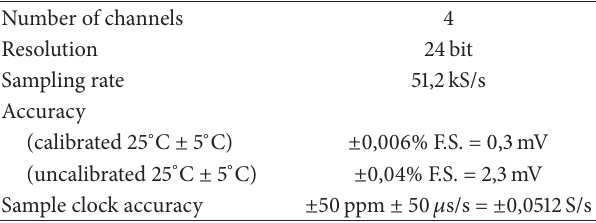
Table 5: IEPE module (NI9234) technical data